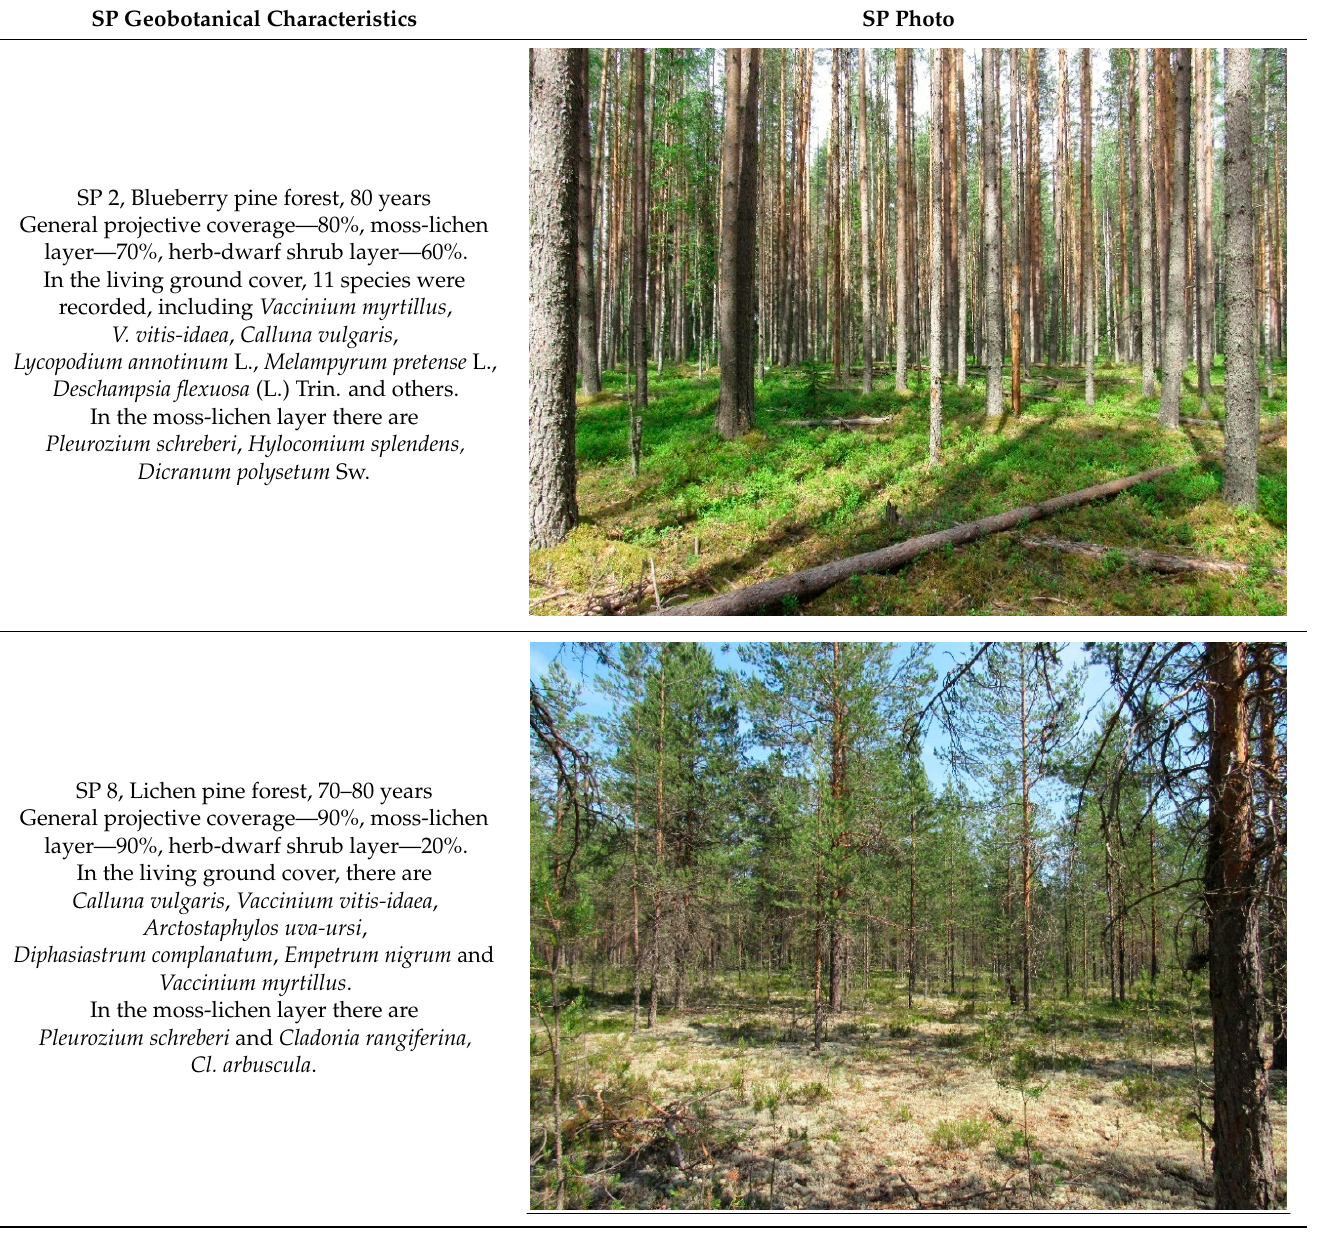
Table 2. Geobotanical characteristics of sample plots.